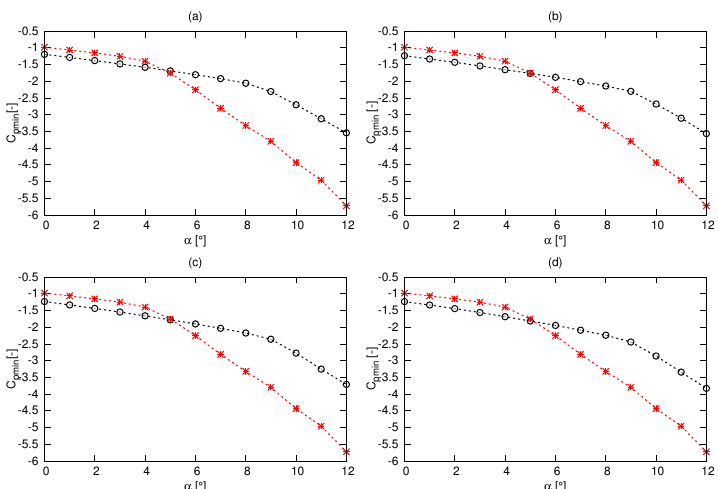
Figure 14. C p of the reference and optimized hydrofoils of the first case of 2D optimization, where min ( a ) is C p of HF-2D-1-1, ( b ) is C p of HF-2D-1-2, ( c ) is C p min min The red and black lines denote optimized and reference hydrofoil, respectively.